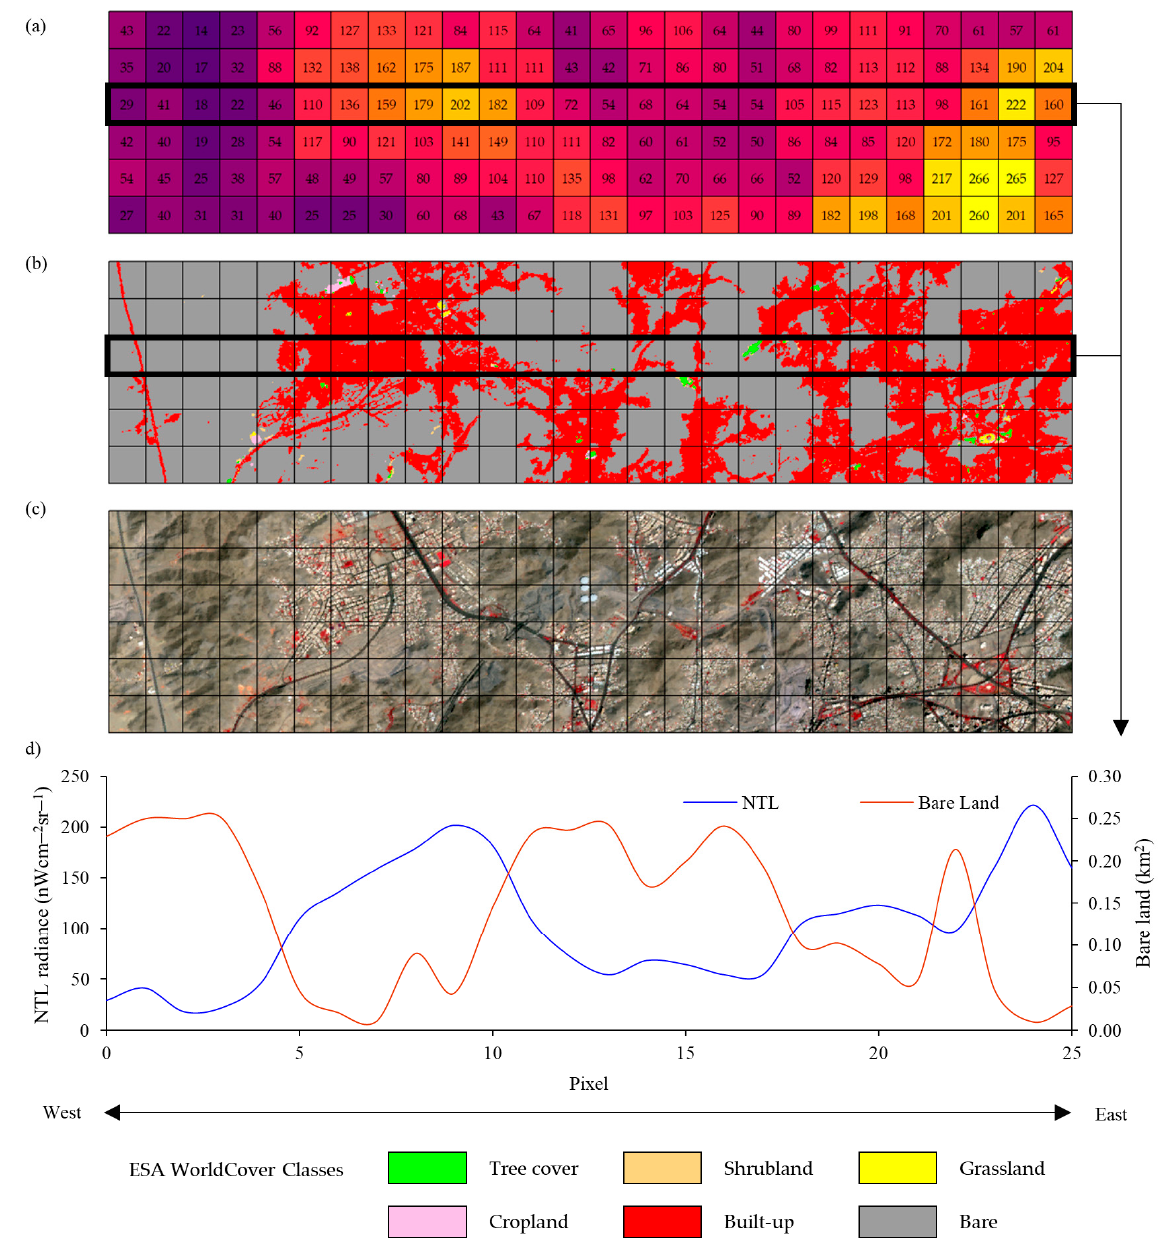
Figure 2. North part of Makkah from west to east over ( a ) NTL (nWcm − 2 sr − 1 ), ( b ) ESA WorldCover 2020, ( c ) Sentinel-2 imagery and ( d ) a longitudinal transect of NTL and bare land.